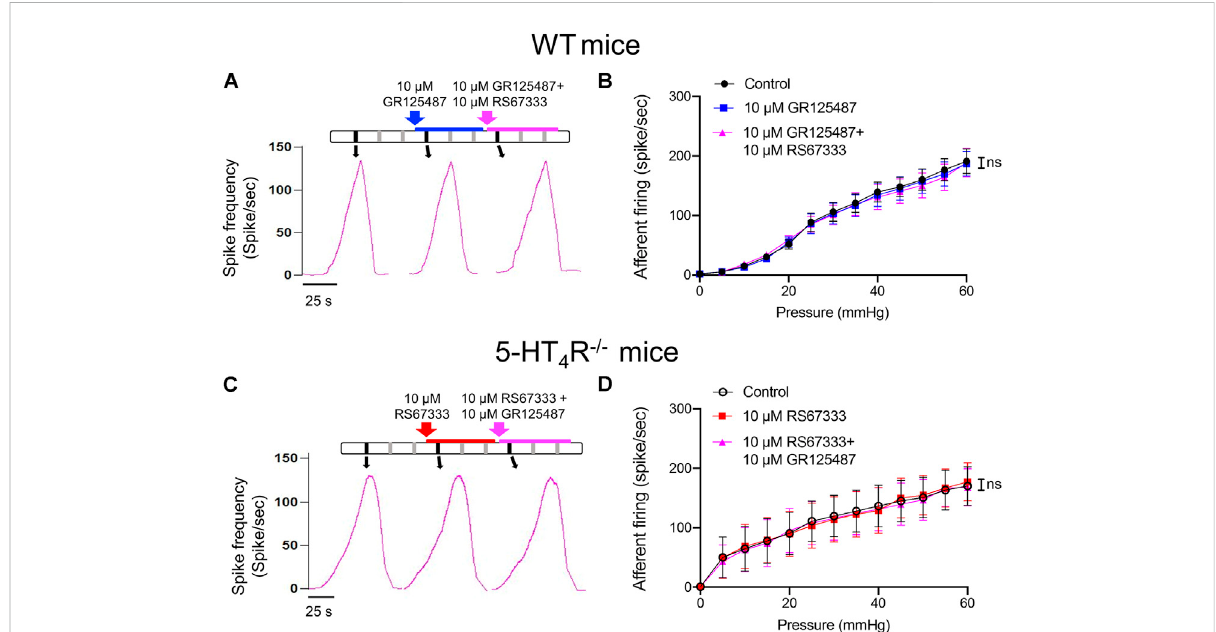
FIGURE 4 RS67333hadnoeffectonthemechanosensoryresponsesofthebladderafferentnervesinthepresenceof5-HT 4 Rantagonistandin5-HT 4 R − / − mice. (A) Schematicofdrugadministrationandtheafferentdischargerateduringrepetitivebladderdistensionsinan exvivo bladderpreparationfrom a WT mouse. (B) Relationship between bladder afferent fi ring and intravesical pressure (ns = not signi fi cant, one-way ANOVA, p > 0.05). (C) Schematic of drug administration and the afferent fi ring rate during repetitive bladder distensions in an ex vivo bladder preparation from a 5- HT 4 R − / − mouse. (D) Relationship between bladder afferent fi ring and intravesical pressure (ns = not signi fi cant, one-way ANOVA, p > 0.05). n = 4 – 5 mice for each group.